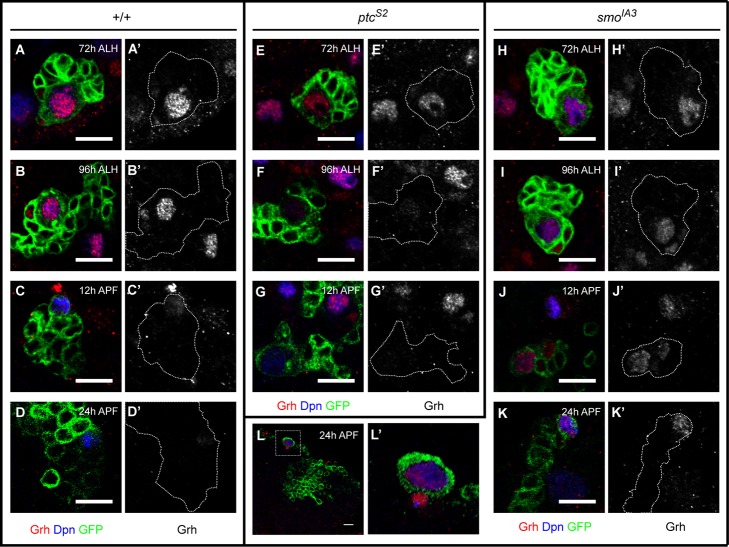
Hh signaling affects the maintenance of grh expression.(A–D′) Grh (red) was expressed in wt NBs (marked by Dpn, blue) and some GMCs at 72 h ALH (A–A′) and 96 h ALH (B–B′). Grh expression was down regulated in the NBs and abolished in the GMCs by 12 h APF (C–C′) and its expression was barely visible at 24 h APF (D–D′). (E–G′) ptcS2 NB showed normal expression of Grh at 72 h ALH (E–E′) but its level quickly decreased by 96 h ALH (F–F′) and was completely abolished at 12 h APF (G–G′). (H–L′) Grh expression was detected in smoIA3 NB and GMCs at 72 h ALH (H–H′), and 96 h ALH (I–I′) but persisted until 12 h APF (J–J′) and failed to be down-regulated at 24 h APF (K–L′). (L) A smoIA3 NB at 24 h APF with persistent Grh expression amidst the wt background (non-green) in which all the NBs had down-regulated their Grh expression. Scale bar = 10 µm.